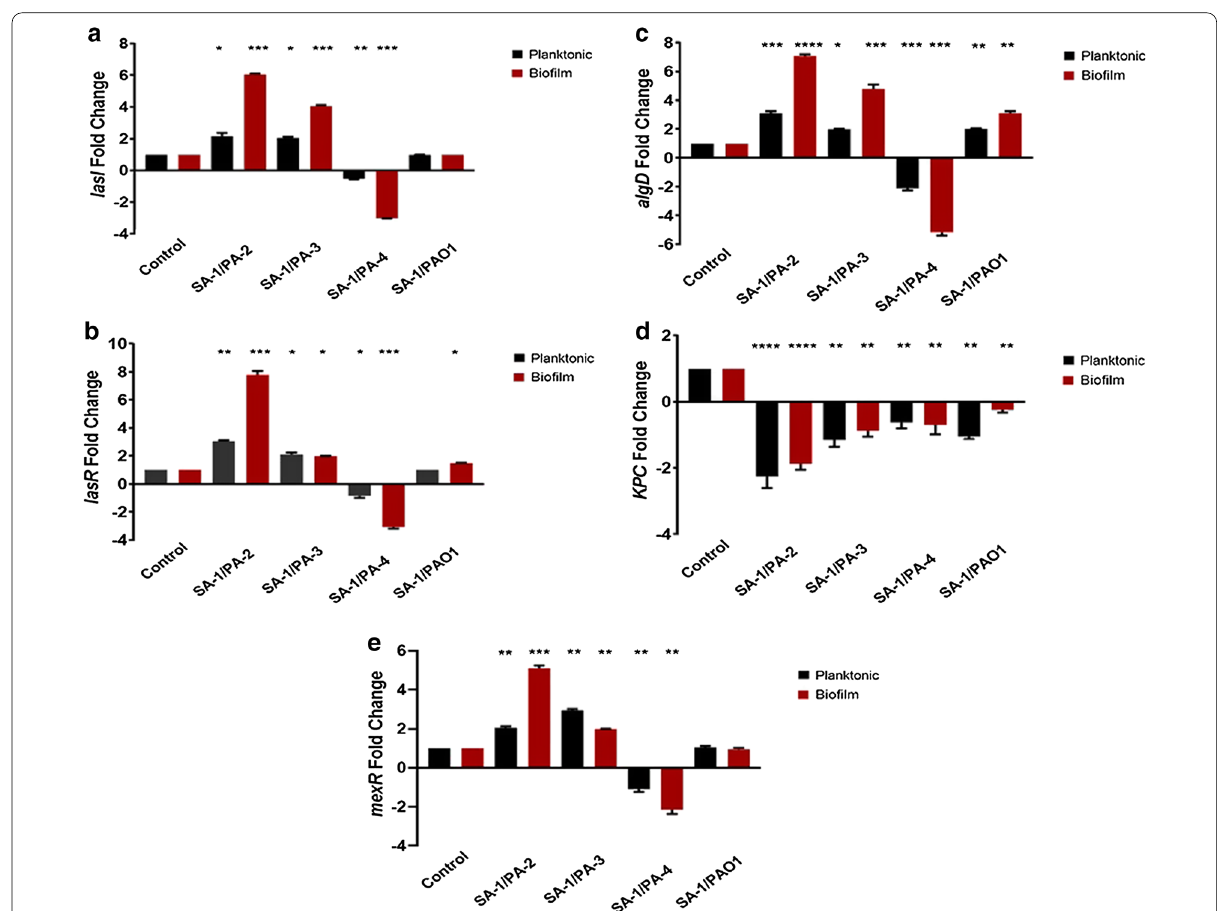
Fig. 3 The expressions of lasI ( a ), lasR ( b ), algD ( c ), KPC ( d ), and mexR ( e ), in P. aeruginosa . The fold changes of the biofilm form in the expressions of lasR , lasI , algD , mexR , and KPC for the infected A549 cells as determined by RT-qPCR. The error bars indicate the standard errors of the means from a representative triplicate time. ’*: p < 0.05 , **: p < 0.001 , ***: p < 0.0001 . No stars: the non-statistical